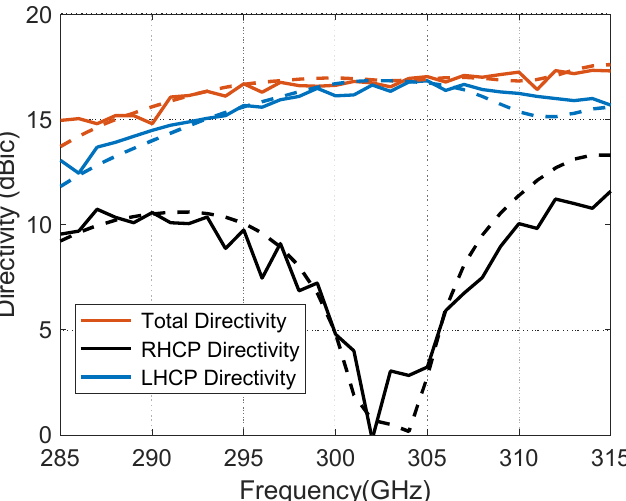
Figure 5. The measured (solid lines) and simulated (dashed lines) of the total, LHCP, and RHCP directivities for the proposed antenna.